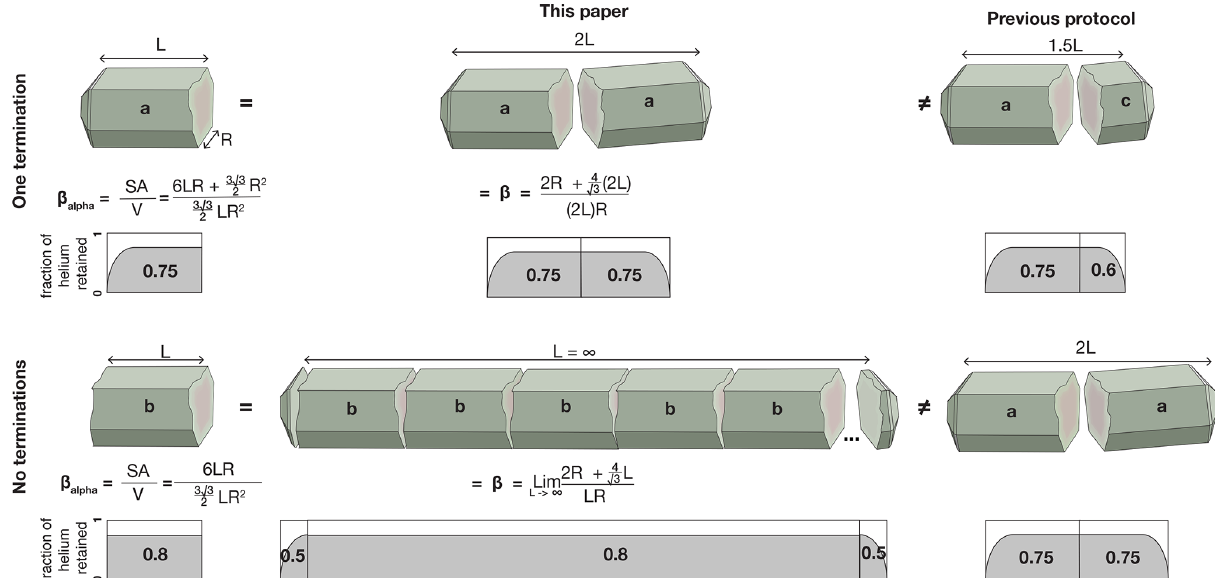
Figure 1. The ratio of alpha-ejection-affected surface area to volume, or β α , of a broken crystal that has lost a basal fragment longer than one alpha stopping distance is equivalent to the surface-area-to-volume ratio of an unbroken crystal that is either twice as long (for fragments with one termination) or infinitely long (for fragments with no termination). The simple geometric calculations shown assume a flat hexagonal termination, but they apply by the same logic to any geometry, regardless of the shape of its body (e.g., cylindrical, tetragonal, or hexagonal) or the shape of its terminations (e.g., pyramidal, flat, or rounded). The profiles of fraction of helium retained that are shown below each fragment are schematic and serve only to illustrate the equivalence or non-equivalence of fragments of different lengths (e.g., a = 0 . 75, b = 0 . 8, c = 0 . 6), and do not correspond to any specific dimensions. As discussed in the text, these calculations assume no change to the daughter concentration profile due to